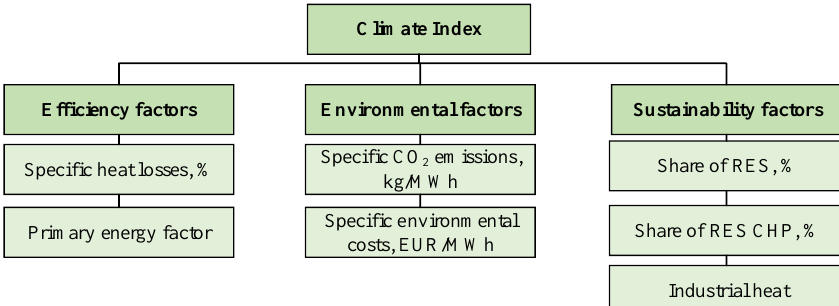
Fig. 2. Criteria merged within the Climate